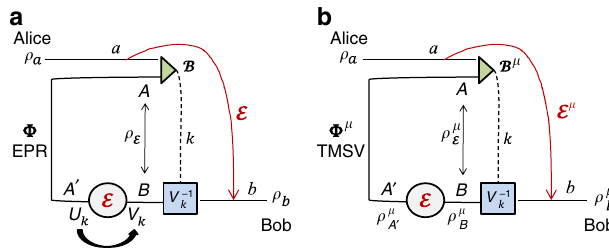
Figure 3 | Teleportation-covariant channels are